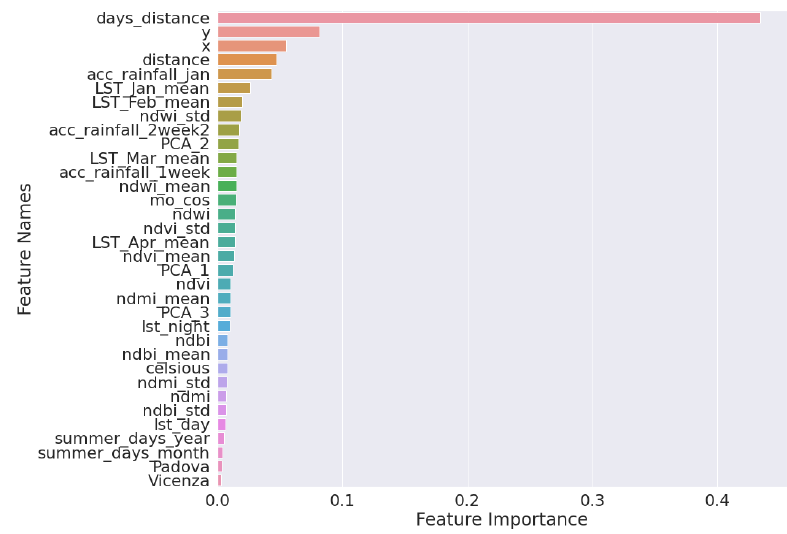
Figure 8. Feature importance of Culex Italy case using only EO